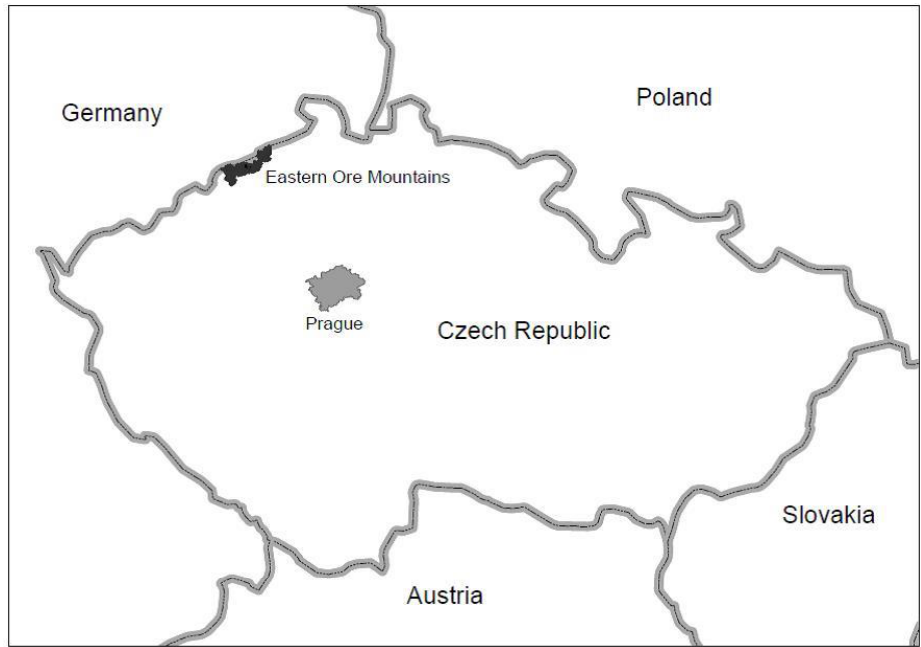
Figure 1. Location of the Eastern Ore Mountains in the Czech Republic (source: authors).